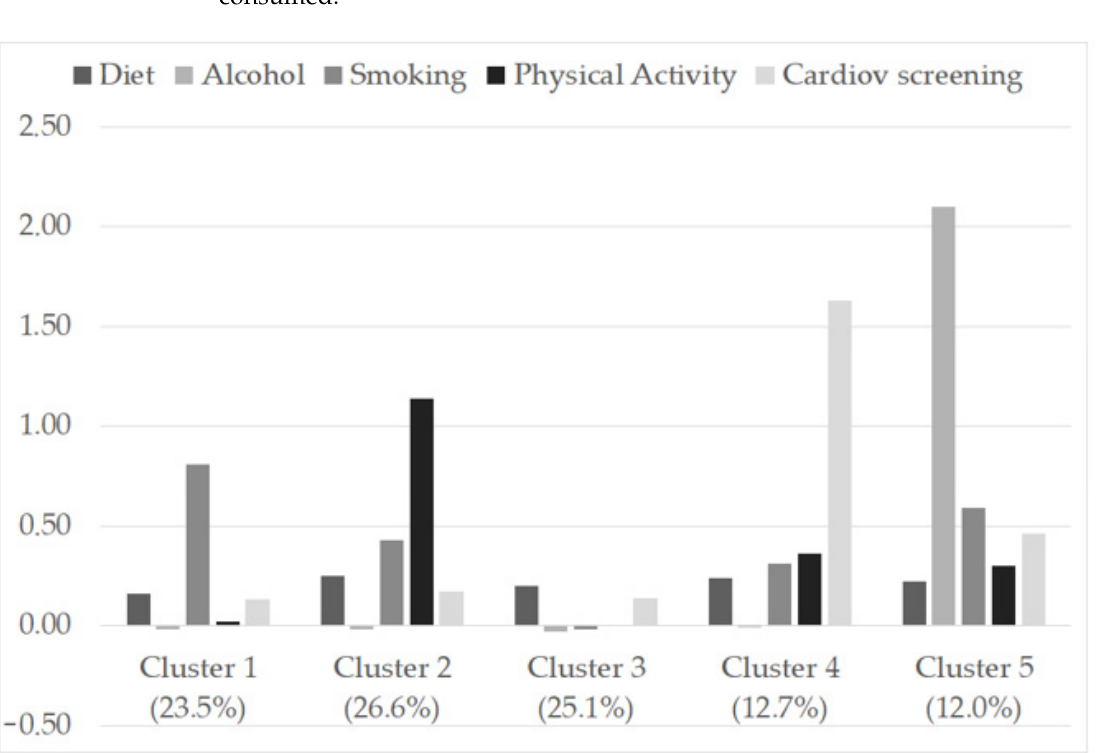
Figure 2. Z-scores for diet, alcohol consumption, cigarette smoking, physical activity, and cardiovascular screening for the final five-cluster